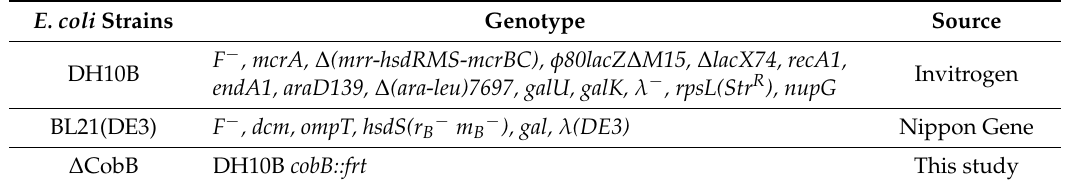
Table A4. E. coli strains in this